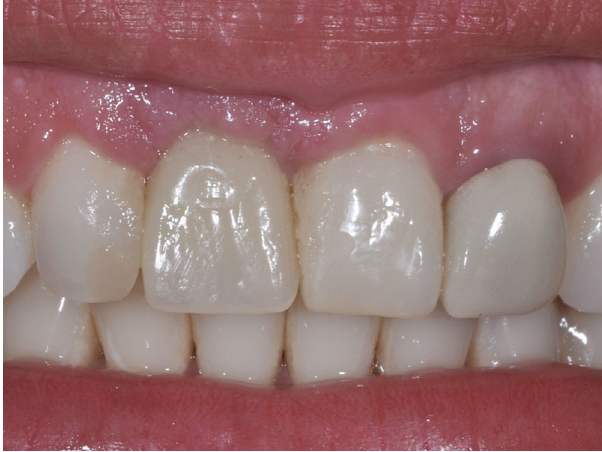
Figure 10: Aesthetic result 3 months after fi nal crown